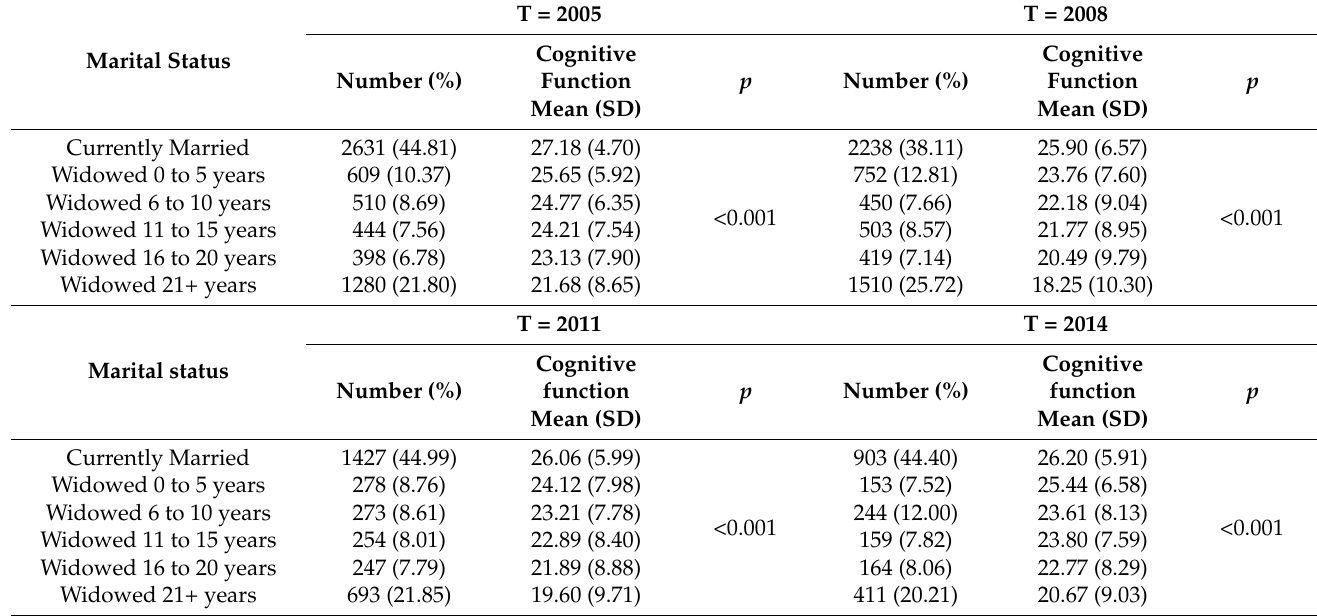
Table 2. Cognitive function based on marital status from 2005 to